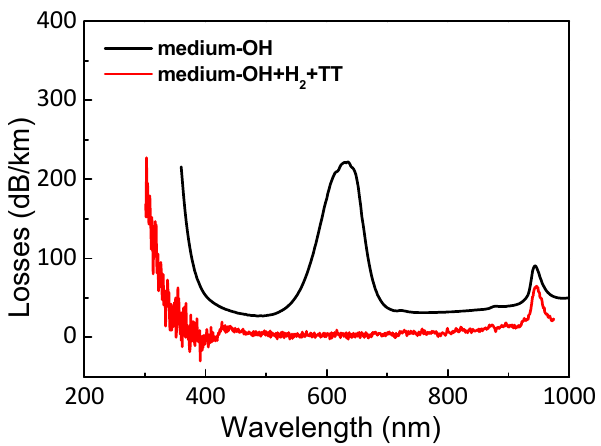
Figure 2. Attenuation spectra of the pristine medium -OH sample before and after the H 2 loading and thermal treatment (TT).